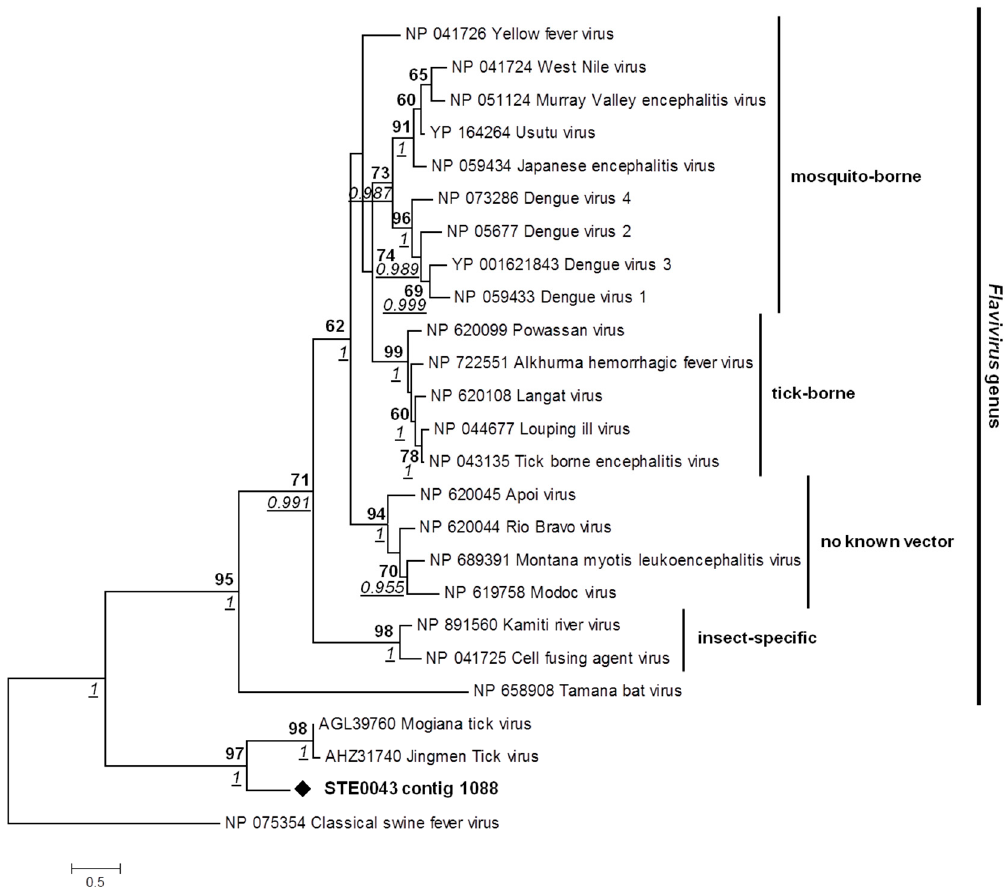
Figure 7. Phylogenetic analysis of Jingmen Tick ‐ like virus. Phylogenetic analysis of a fragment of 319 amino ‐ acids of the NS5 segment. ML analysis was used to fix tree topology. ML analysis was performed on 1000 iterations. Bootstrap values above 60 and posterior probabilities above 0.5 are indicated. Bayesian posterior probabilities are underlined and represented in italics where nodes coincided with ML. Substitution models for ML and Bayesian analyses were determined as LG+G and rtREV+ G, respectively. Scale bar indicates the number of amino ‐ acid substitutions per site.